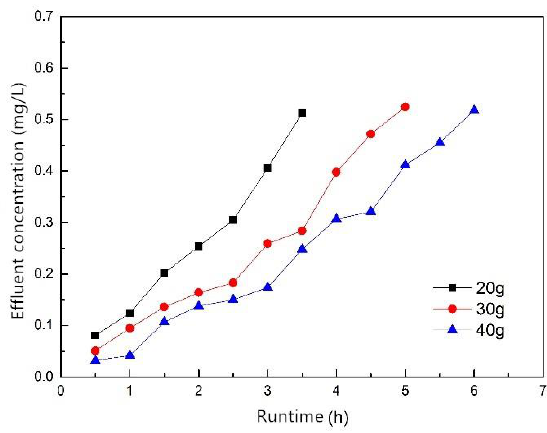
Figure 10. Breakthrough curves of different filler mass.